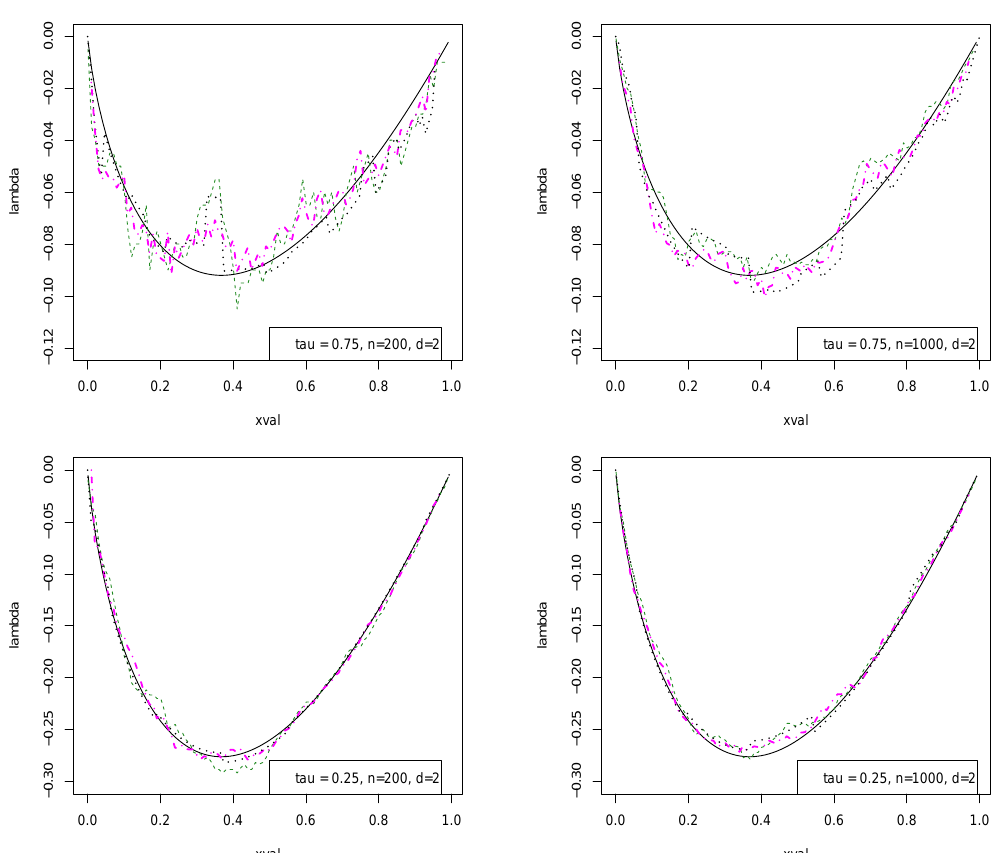
Figure 10. Estimation of λ function. Black: theoretical λ function. Dark green dashed line: b λ G ( u ) (estimator proposed by Genest et al. [25]), Black dotted line: b λ ( u ) (i.e., our estimator using Equation (28) ). Violet dotted-dashed line: b λ ∗ ( u ) (i.e. our estimator using Equation (29) ). Parameters setting : n = 200 , (right column) and n = 1000 (left column), d = 2 . Kendall’s tau parameter is τ = 0 . 75 ( θ = 4 ) (upper row) and τ = 0 . 25 ( θ = 1 . 333 ) (bottom